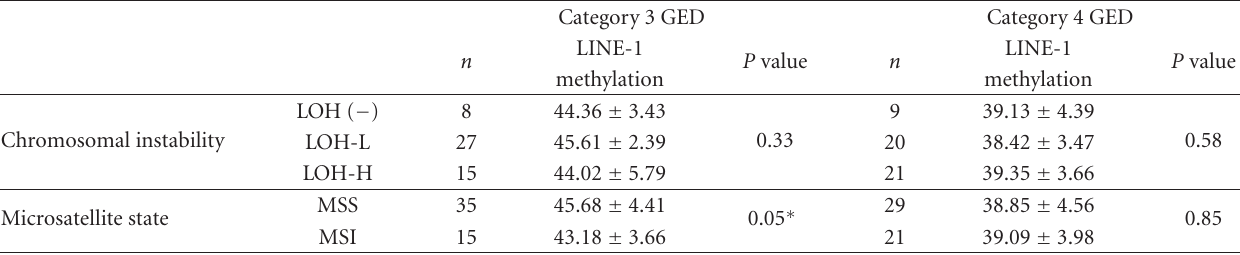
Figure 3: Level of LINE-1 hypomethylation of gastric epithelial dysplasia according to H. pylori state and genetic instability. (a) Irrespective of H. pylori infection, there were no di ff erences of LINE-1 methylation level between LOH-L and LOH-H. (b) In dysplasia with H. pylori infection, LINE-1 methylation level of MSI is significantly reduced than that of MSS. Box plots illustrate median values, 25th and 75th percentiles, and outliers on a linear scale. The unpaired t test was applied for nonparametric statistical analysis, and ∗ was considered statistically significant ( P < 0 . 05). Table 2: LINE-1 methylation level according to genetic instability (chromosomal instability and microsatellite instability) in gastric epithelial dysplasias categorized by the revised Vienna